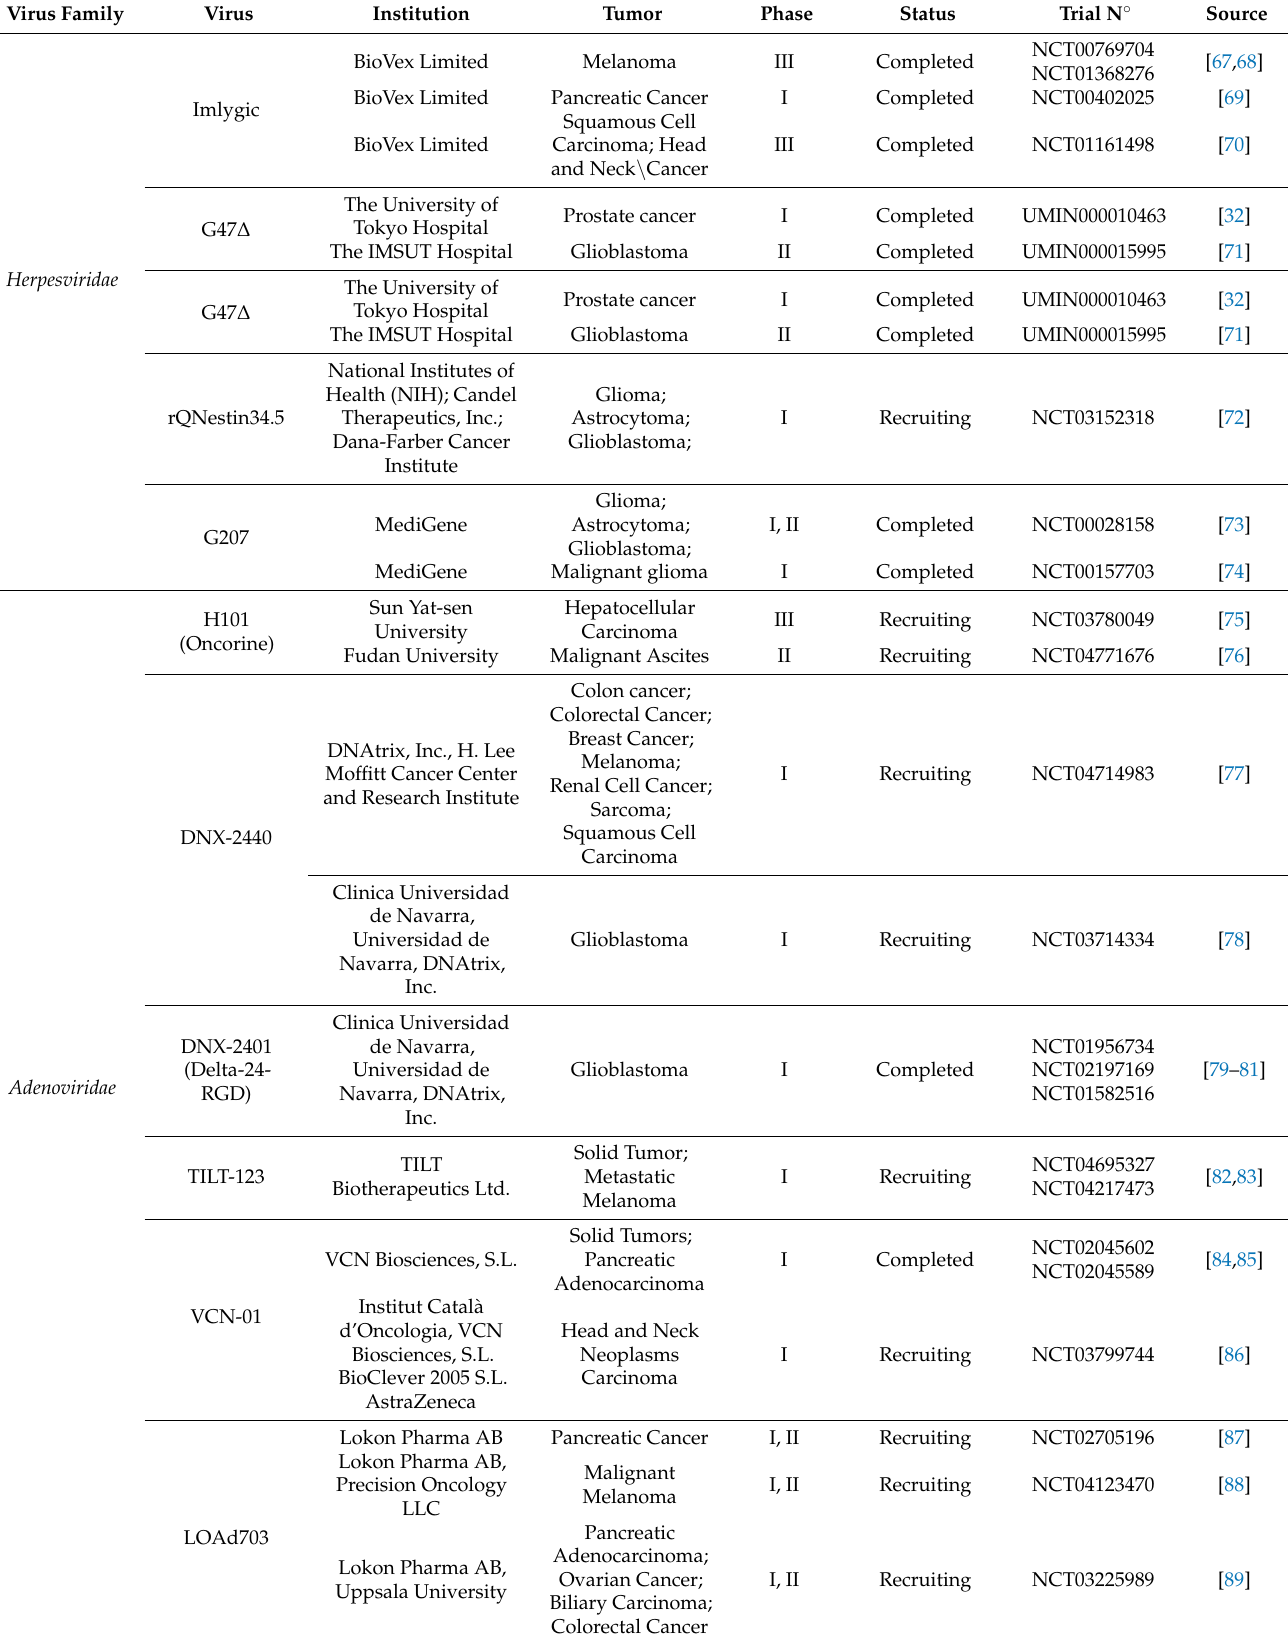
Table 1. Oncolytic viruses subjected to clinical